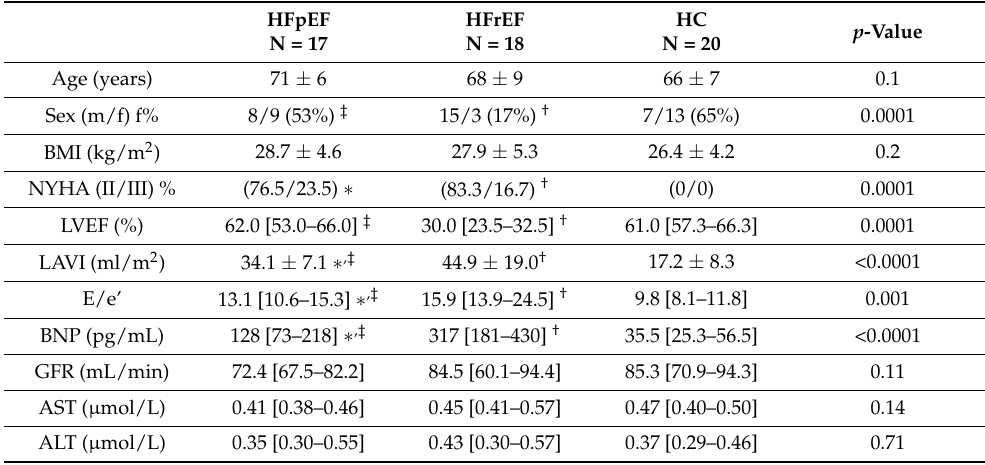
Table 1. Basic characteristics in patients with HFpEF, HFrEF, and HC.